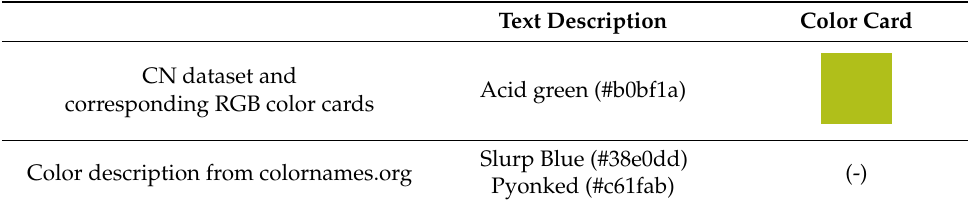
Table 5. Data samples for evaluation.